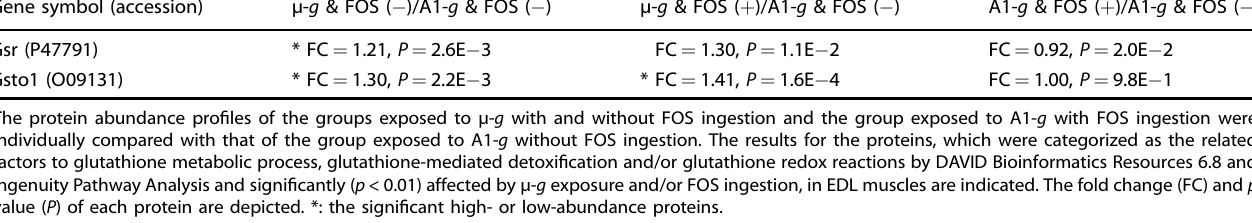
Table 3. Responses of extensor digitorum longus (EDL) muscle proteins involved in glutathione-mediated detoxi fi cation and glutathione redox reactions to microgravity (µ- g ) or arti fi cial 1- g (A1- g ) exposure and/or fructo-oligosaccharide (FOS) ingestion.